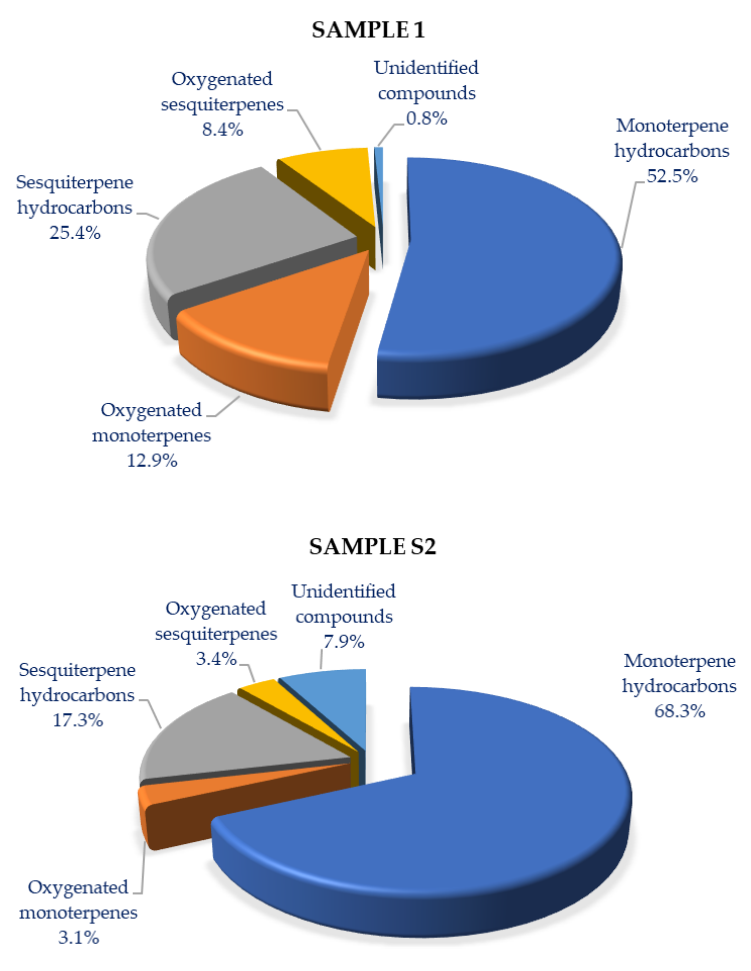
Figure 1. Fractions of terpenoid classes in the samples of wild-growing Sideritis sipylea populations from Greece (S1: mid-summer collection, Samos Island; S2: early summer collection, Lesvos Island). It might be noticed that, in both S. sipylea Greek samples, monoterpene hydrocarbons were the dominant class in the studied EOs (Figure 1) and their content was 68.3% in S2 and 52.5% in S1. The fraction of the rest of the terpenoid classes was higher in the mid- summer S1 sample, while this difference was mostly notable in the case of oxygenated monoterpenes (12.9 versus 3.1% for S1 and S2, respectively). It might be also referred that the content of unidentified compounds was higher in the early summer S2 sample than in the mid-summer S1 sample (7.9% versus 0.8%, respectively).